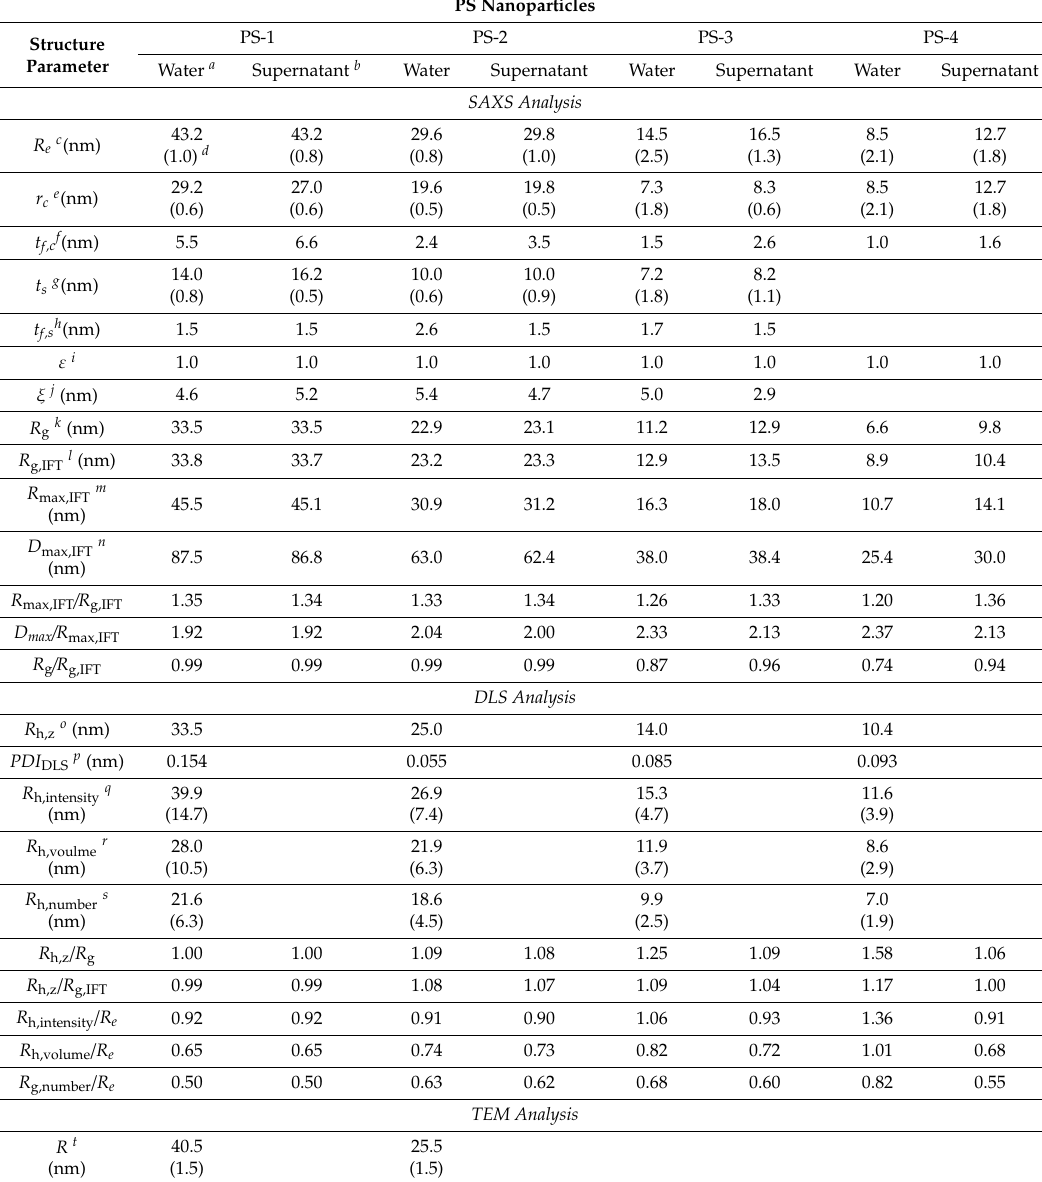
PS Nanoparticles